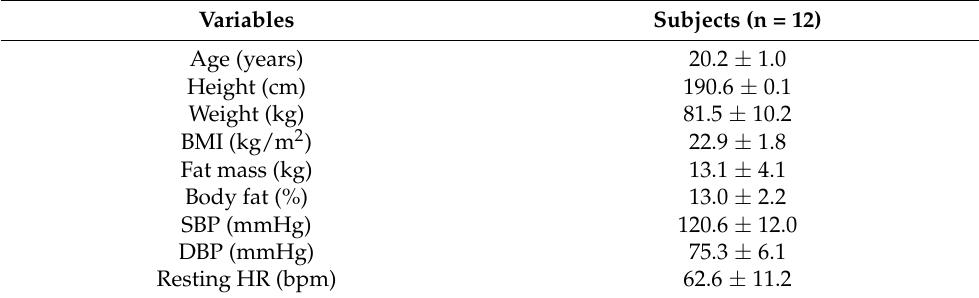
Table 1. Physical characteristics of